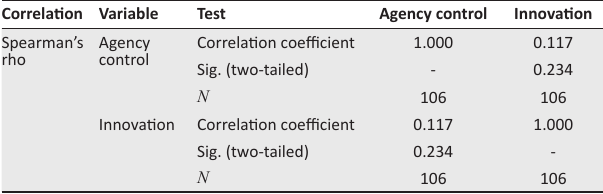
TABLE 3: Spearman’s correlation on agency control versus innovation.